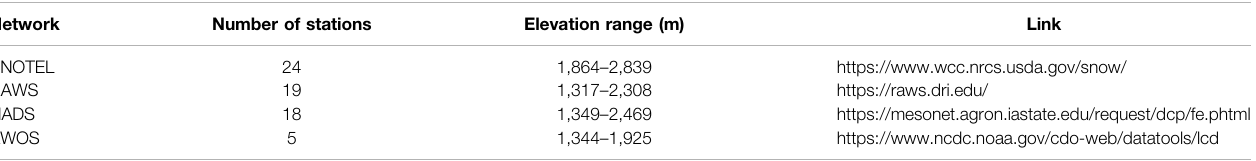
TABLE 1 | Networks of meteorological stations used in this study.